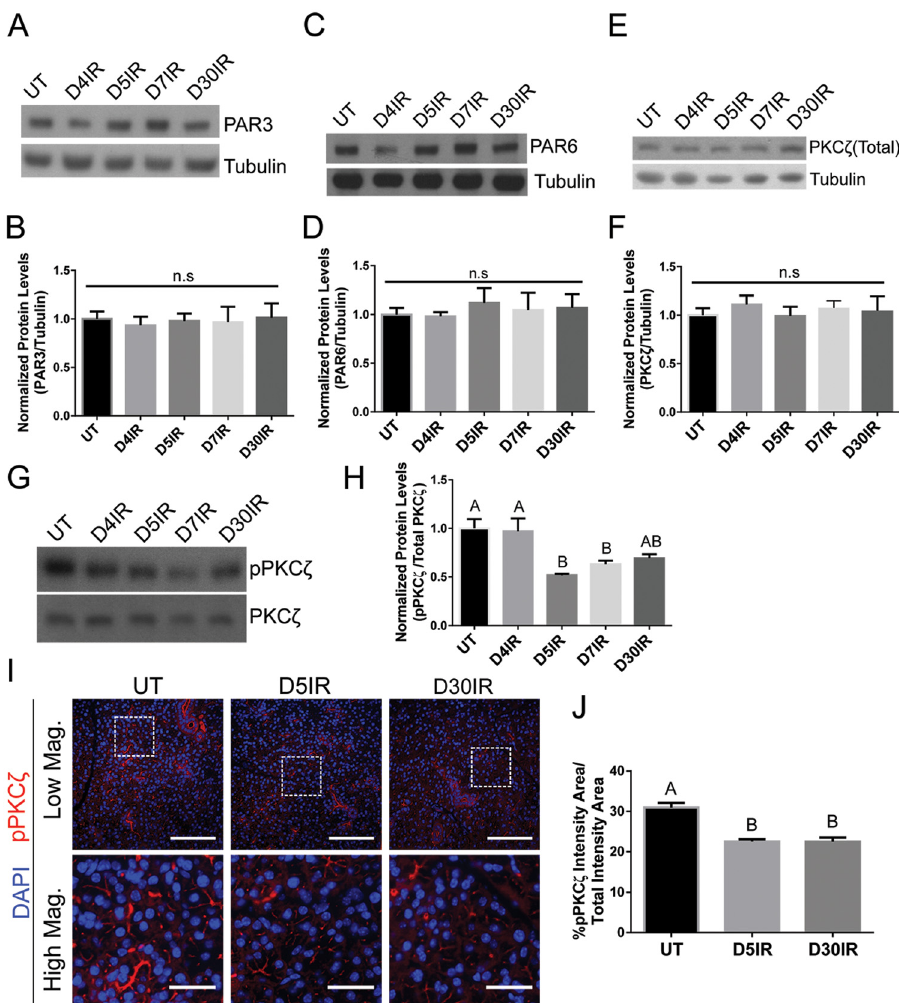
Fig 1. Radiation decreases pPKC z -T560 but not total levels of the PKC z /Par3/Par6 complex. FVB mice were either untreated (UT) or irradiated (IR) with 5Gy and dissected on days 4, 5, 7, and 30 following radiation treatment. Total protein levels of (A-B) Par3, (C-D) Par6, (E-F), total PKC z , and (G-H) pPKC z -T560 were evaluated following radiation treatment. Immunoblots were re-probed with β -tubulin or PKC z as a loading control. (I) Immunofluorescent staining was used to determine the intensity area of pPKC z -T560 (red) in comparison to the total area. Composite images with DAPI (blue) are presented in both high and low magnification views (scale bar for high magnification = 30 μ m, low magnification = 100 μ m). (J) Quantification of the percentage of pPKC z -T560 positive area within the parotid gland. Results are presented from at least three mice per condition; I-J used 10–15 images per mouse; error bars denote mean ± SEM. Significant difference (p < 0.05) was determined by a Tukey-Kramer test for multiple comparisons. Treatment groups with different letters above the bar graphs are significantly different from each